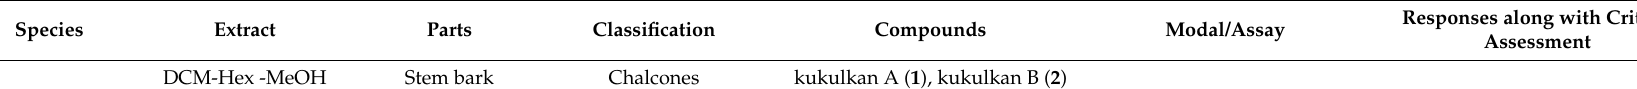
Table 2. Bioactive metabolites of genus Mimosa and their pharmacological